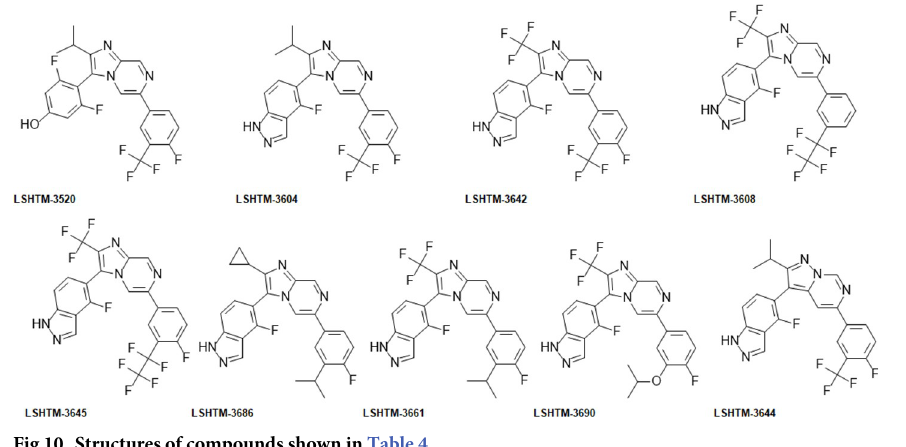
Fig 10. Structures of compounds shown in Table